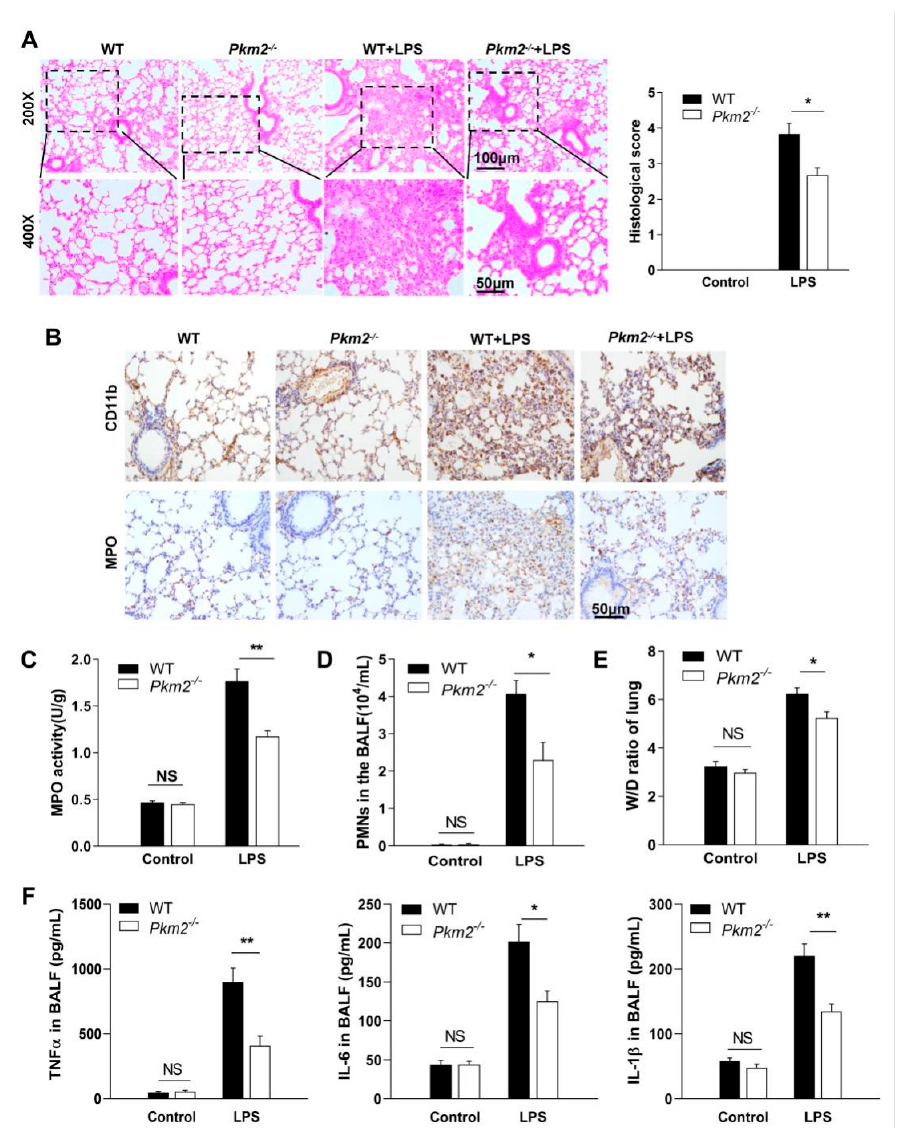
Figure 4. Myeloid-specific Pkm2 deficiency protects mice against LPS-induced ALI. ( A ) Left, representative H&E staining of lung tissue sections in mice with or without exposure to intratracheal LPS. Right, the histology score of H&E staining. Lung injury was scored by examining the following parameters in a double-blind manner: pulmonary edema, inflammatory infiltration, hemorrhage, atelectasis, and hyaline membrane formation. n = 5–6. For each slide, 3–5 views were analyzed. ( B ) IHC staining of CD11b and MPO in mouse lungs with or without LPS treatment. ( C ) MPO level in mouse lungs with or without LPS treatment. ( D ) PMNs recovered in the BALF of mice after 24 h exposure to intratracheal LPS. ( E ) Mouse lung W/D ratio at 0 or 24 h post-LPS treatment. ( F ) The IL-1 β , IL-6, and TNF- α contents in BALF were measured using ELISA analysis. Data are represented as mean ± SEM. * p < 0.05, ** p <